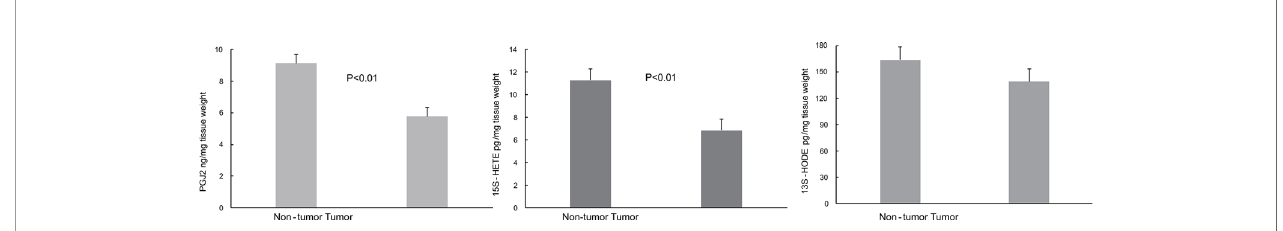
FIGURE 1 | The concentrations of PGJ2 and 15(S)-HETE in PTC. Thyroid tumor tissues and its matched non-tumor tissues were obtained from 32 patients. The concentrations of PGJ2 and 15(S)-HETE were measured using ELISA kits from Cayman Chemical (Ann Arbor, MI) and Enzo Life Sciences (Farmingdale, NY). The ELISA was performed according to the instructions of the manufacturers. The concentrations of these 2 ligands were expressed in ng or pg per mg wet weight of